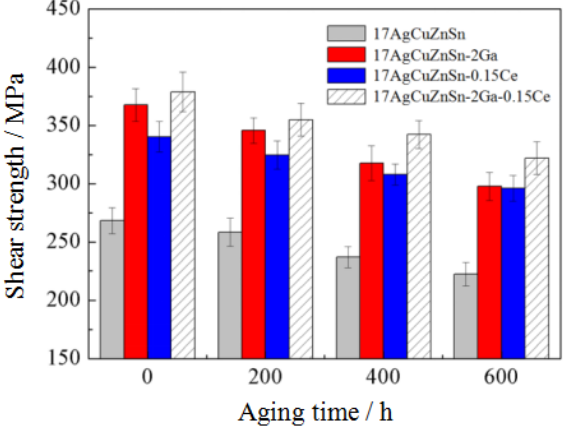
Figure 9. Shear strength of Ag16.5CuZnSn-xGa-yCe after the aging treatment.